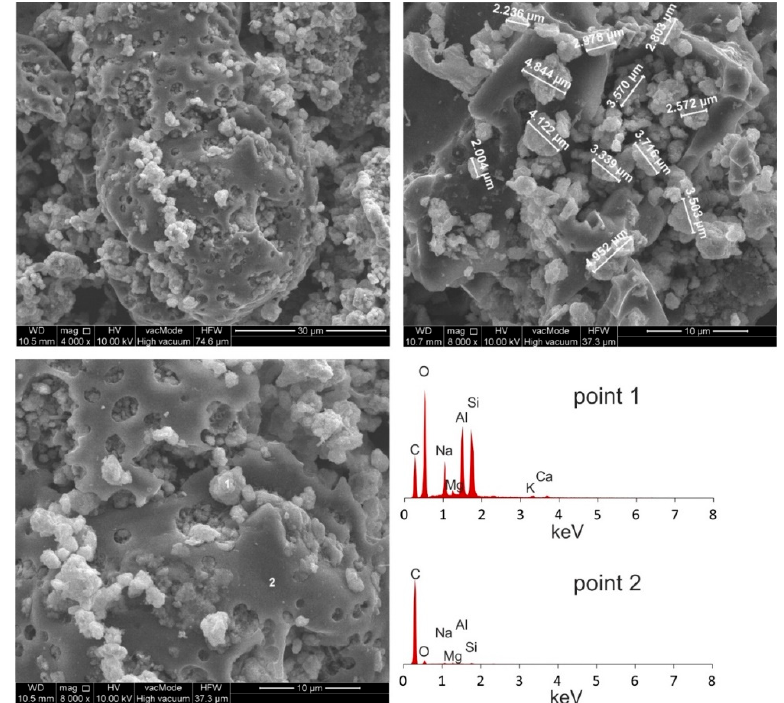
Figure 3. Morphological analyses of Na ‐ P1(C).